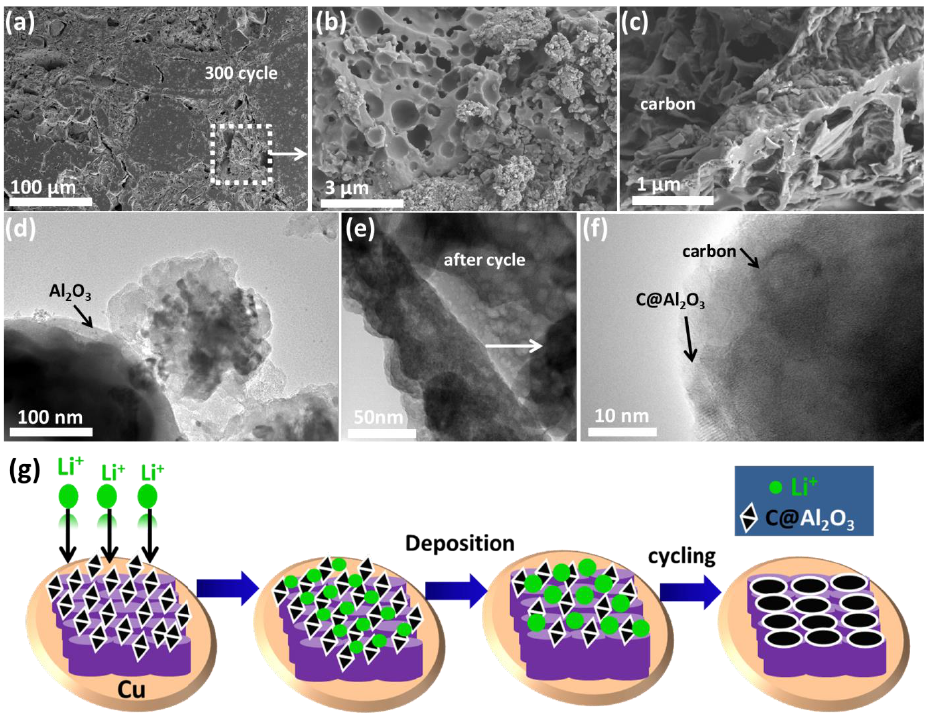
Figure 6. TEM images of C@Al 2 O 3 electrodes ( a ) after 200 cycles and ( b , c ) structure stability, Al 2 O 3 rich coating, crystalline profile and cracking regions, ( d – f ) Li-ion pathway during charge/discharge testing, ( g ) scheme of Li-ion transportation during cycling in charge/discharge process.